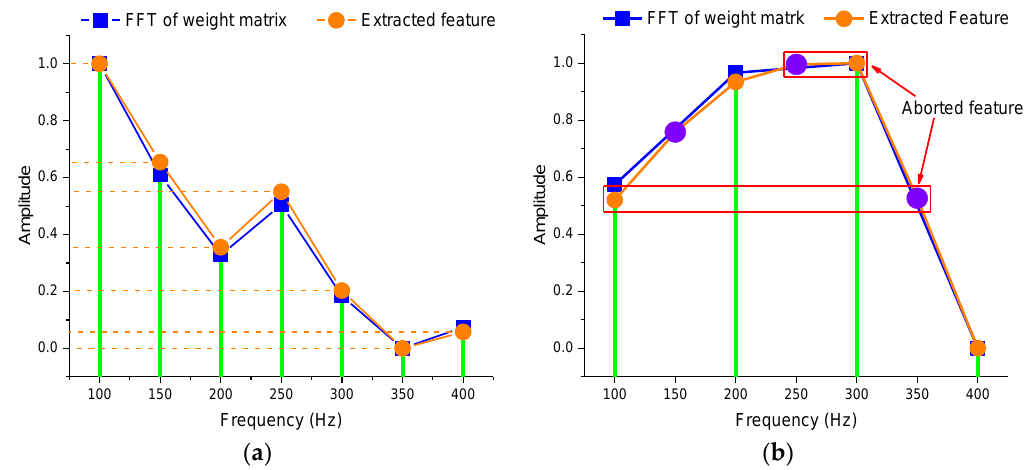
Figure 5. Relationship between the frequencies of samples and the learned features: ( a ) N in = 200; ( b ) N in = 100.